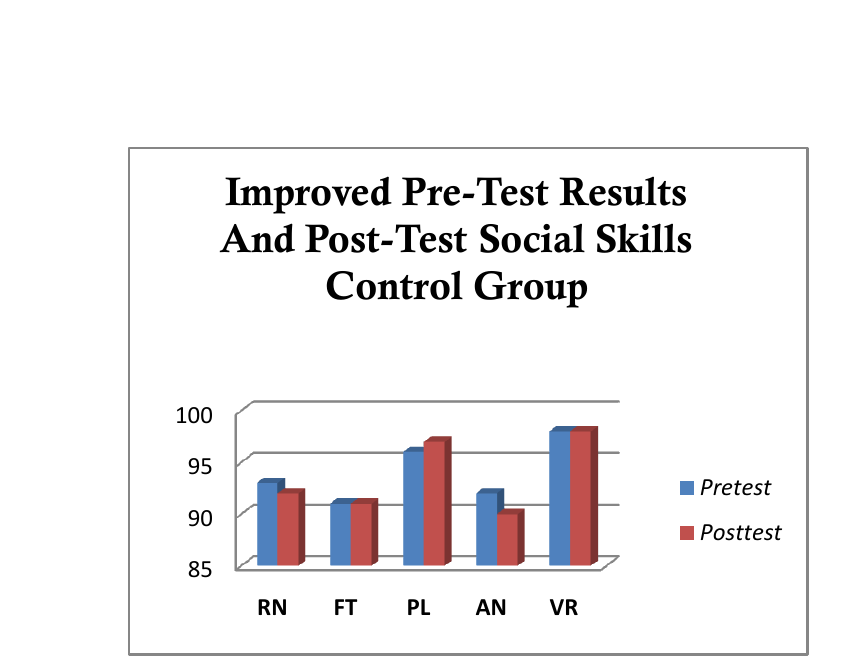
Figure 2 Graph of Pretest Development and Posttest of Social Skills Control